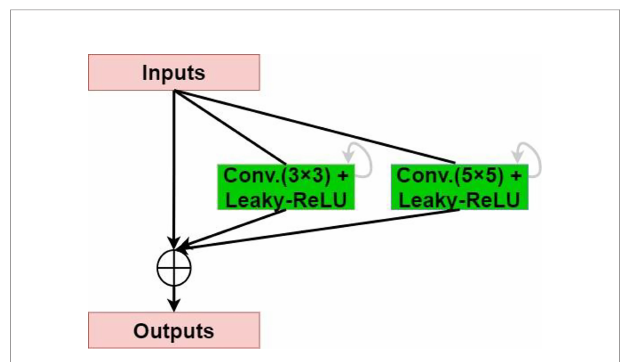
FIGURE 3 | Recurrent-residual-parallel convolutional network (R2P).